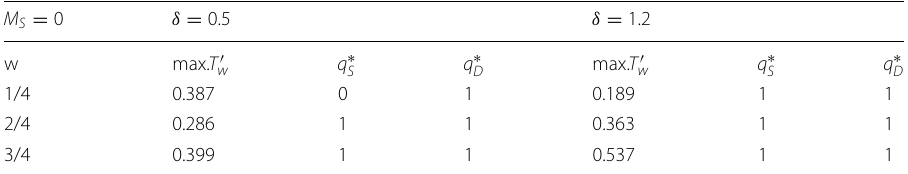
Table 11 The values of q ∗ queue at S is unstable, α = 0.7, M U = 200, M D = 1000, and M S = 0 M S = 0